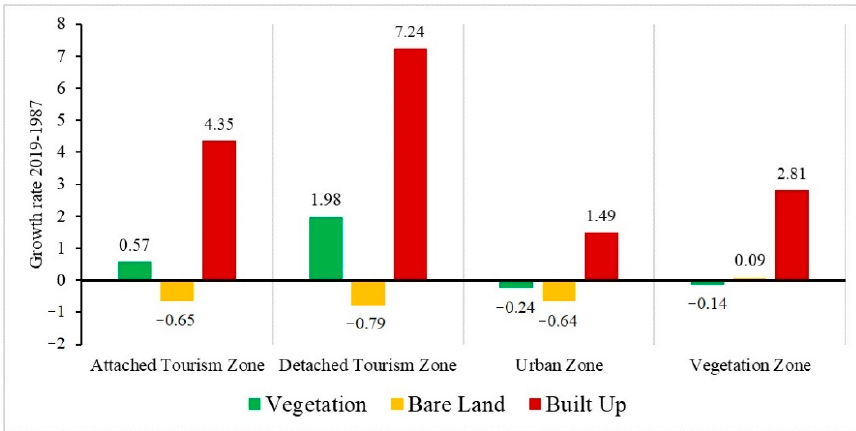
Figure 10. Land use changes rates in the main zones of the study area (1987-2019).